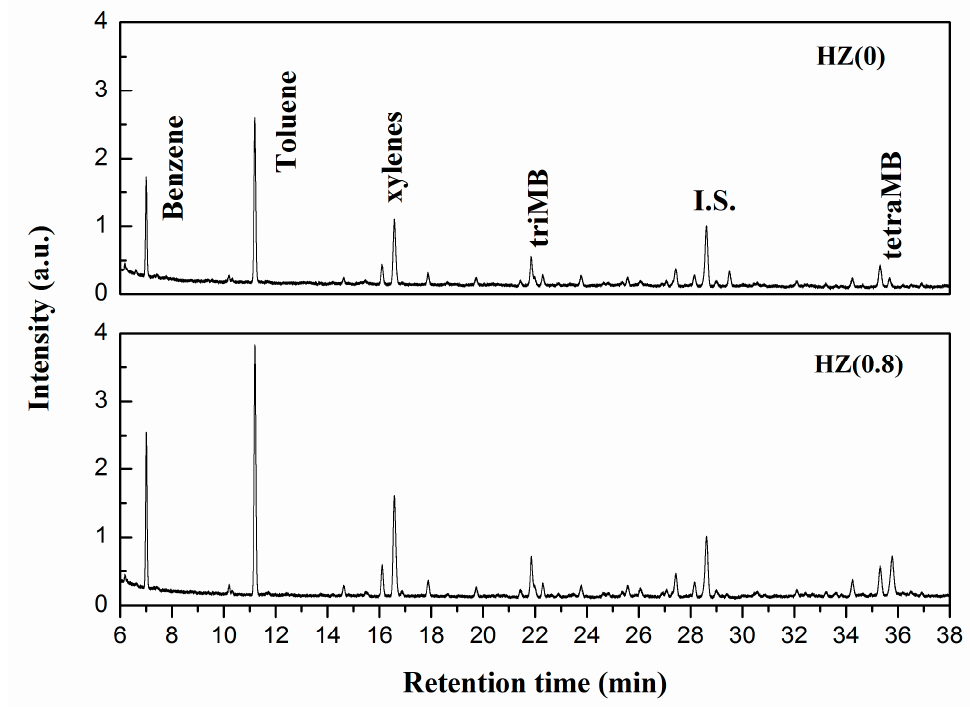
Figure 7. GC-MS spectra of the retained products in HZ(0) and HZ(0.8) catalysts after pulse of propane at 500 °C, which are normalized to the I.S. intensity.